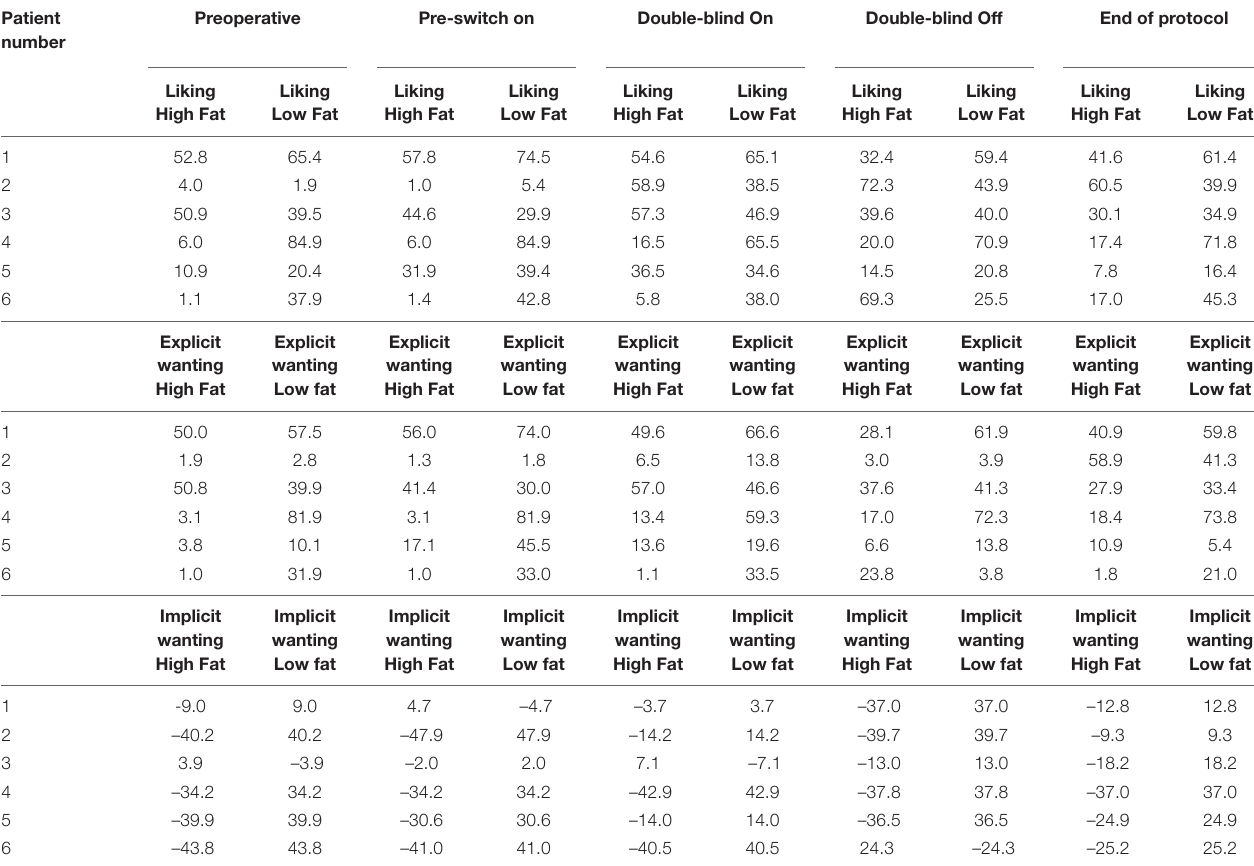
TABLE 8 | High fat and low fat are collapsed across sweet and savory categories. Patient